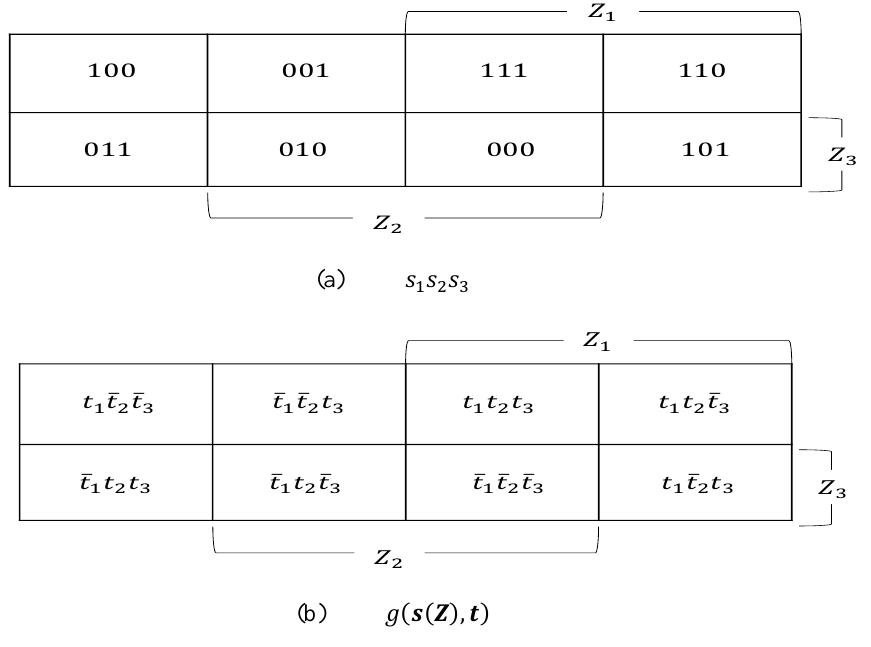
Fig. 18. Map for the functions 𝑠